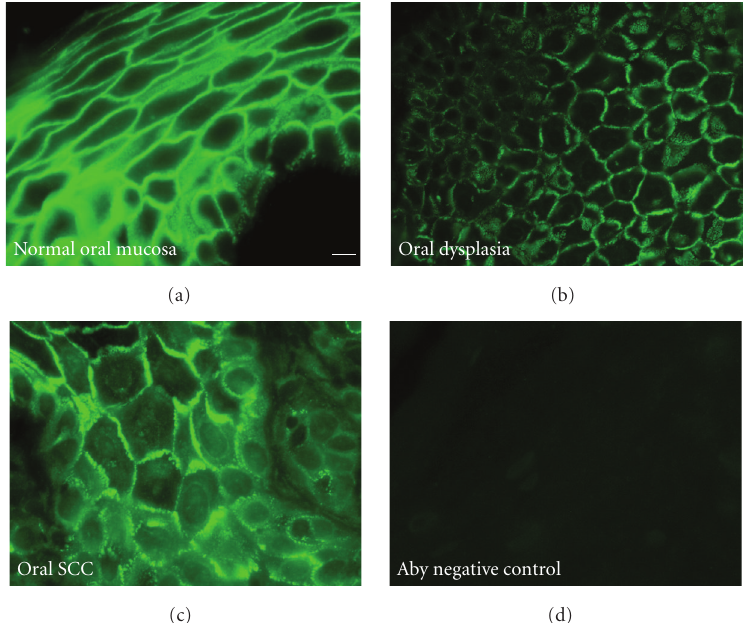
Figure 4: Representative anti-desmoglein-1 staining of oral tissues. Anti-desmoglein-1 monoclonal antibody (27B2) was used to stain normal oral mucosa (a), dysplastic oral mucosa (b), and oral squamous cell carcinoma (c). Normal oral mucosa processed in the absence of primary antibody serves as a negative control (d). The scale bar in panel A corresponds to 10 μ m.